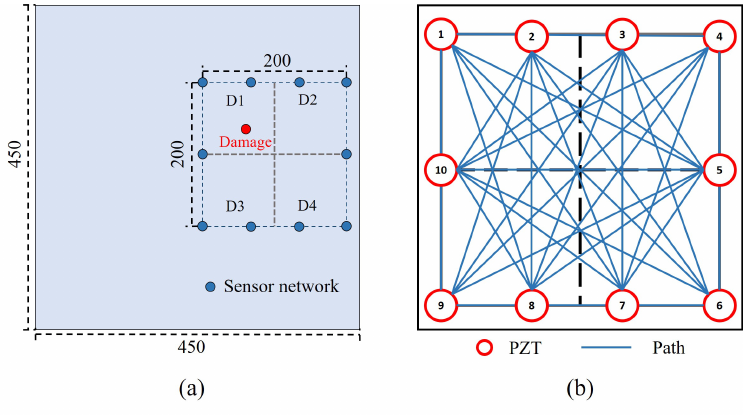
Figure 7. ( a ) Sensor arrangement in composite plate testbed; ( b ) Signal transmission route in compos- ite plate